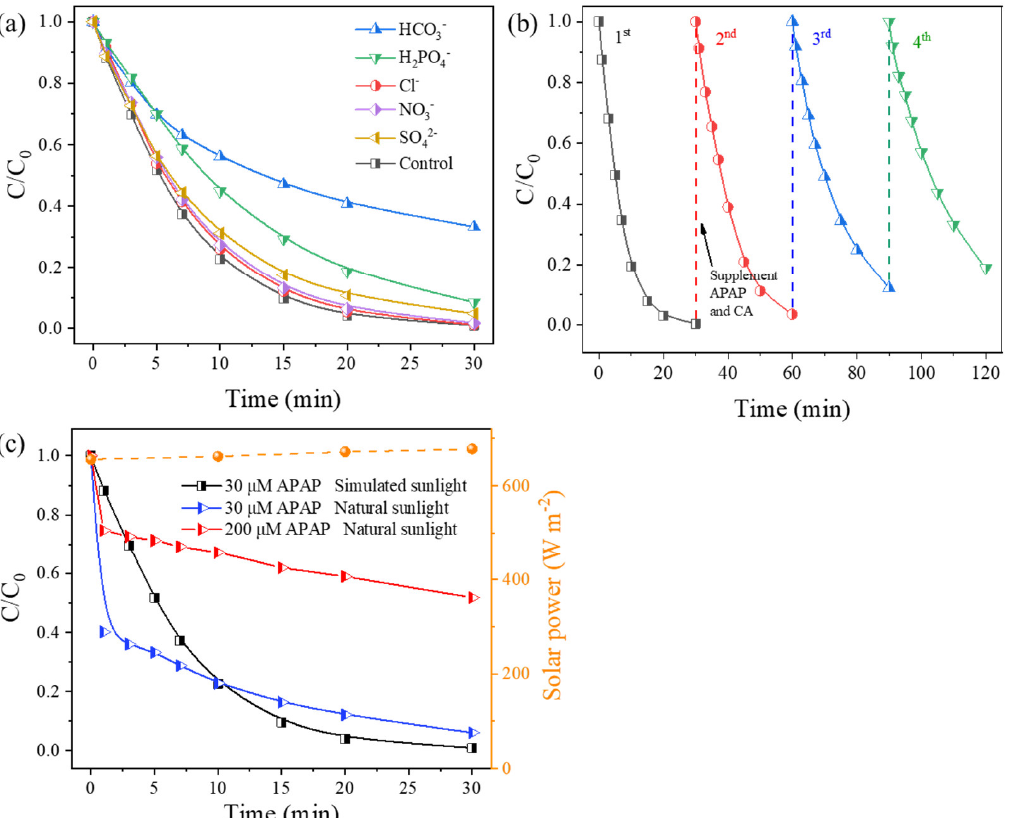
Figure 4. Performance of APAP degradation in the pyrite–CA–light system with ( a ) various co-existing anions, ( b ) the reused pyrite and ( c ) natural sunlight as irradiation source. Initial conditions: [Cl − ] = [NO 3– ] = [SO 42− ] = [H 2 PO 4− ] = [HCO 3– ] = 5 mM, [pyrite] = 0.1 g L −1 , [APAP] = 30 μM, [CA] = 0.6 mM, pH ini = 6.